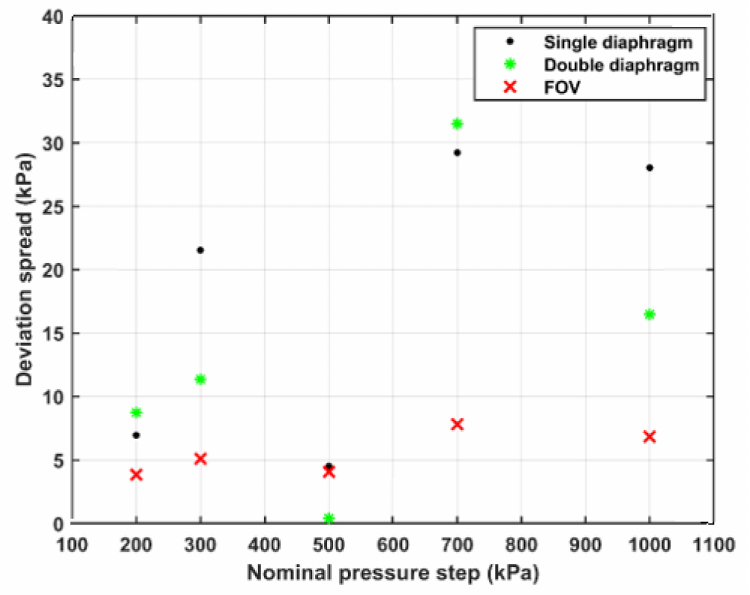
Figure 7. The deviation spread at different nominal pressure steps, using the three operating modes. Sources for variations in shock amplitude common for all modes of operation com- prise variations in initial parameters, such as driven pressure ( p 1 ), driver pressure ( p 4